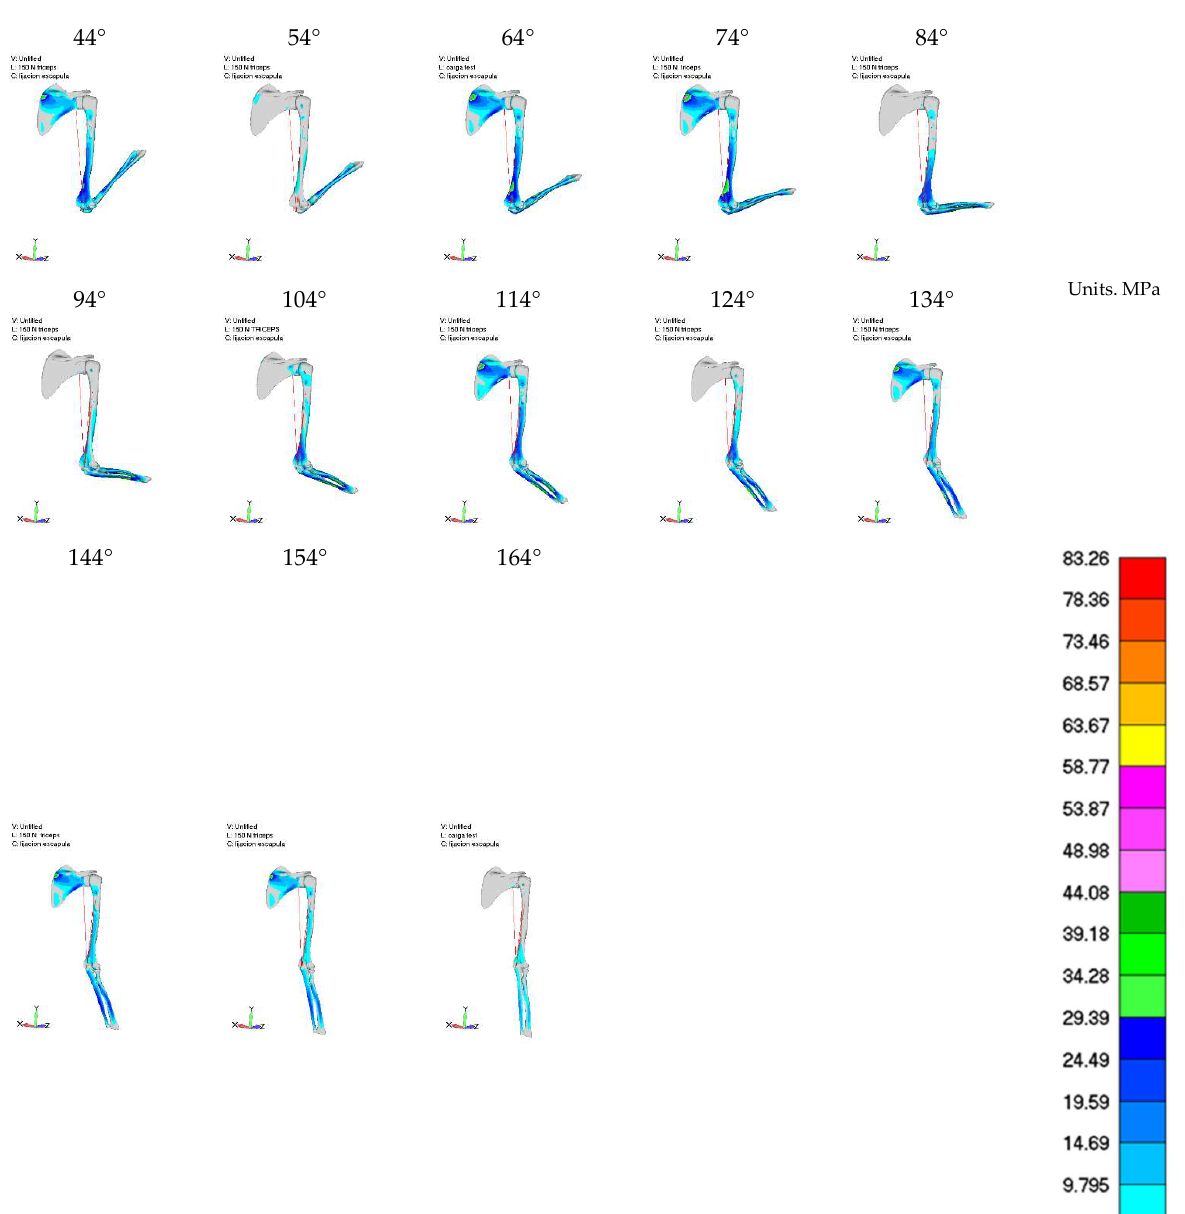
Table 2. Axial efforts (N) in main simulated muscles, 150 N applied on wrist. Isometric contractions at each angle value considered.